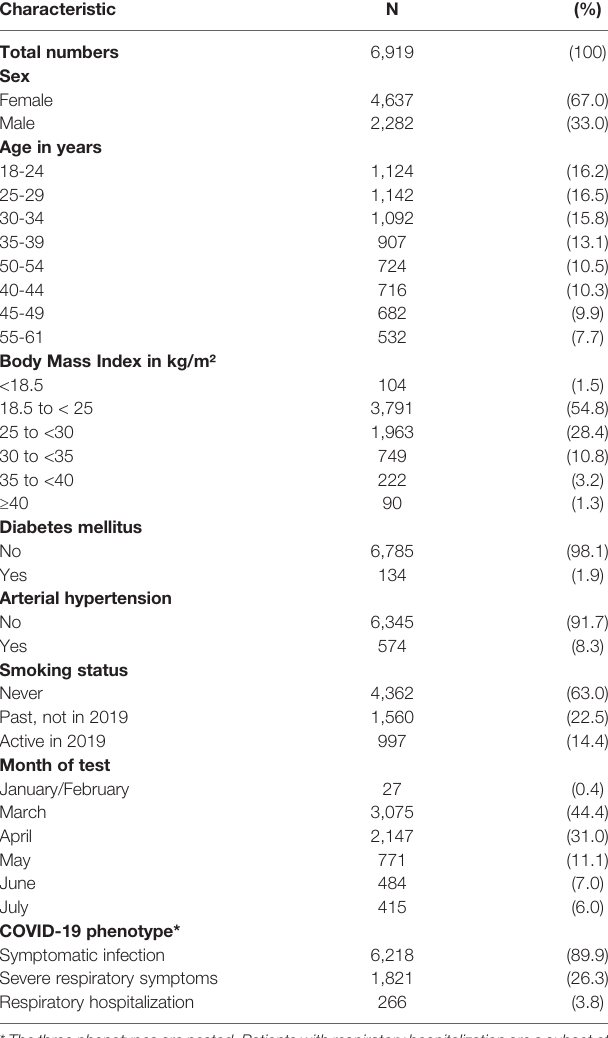
TABLE 1 | Characteristics of SARS-CoV-2 positive